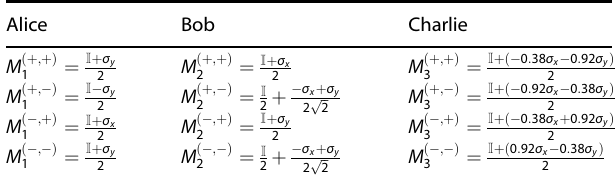
Table 1. Optimal projective measurement settings for each player in three-user GYNI CCP